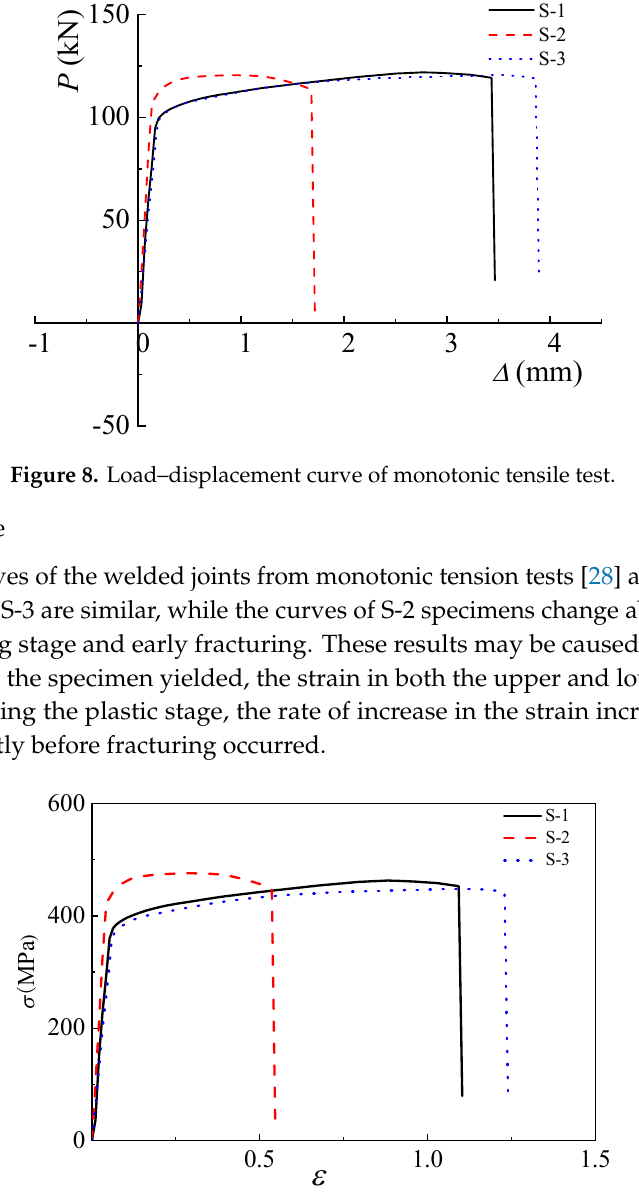
Figure 9. Stress–strain curves of monotonic tensile tests.